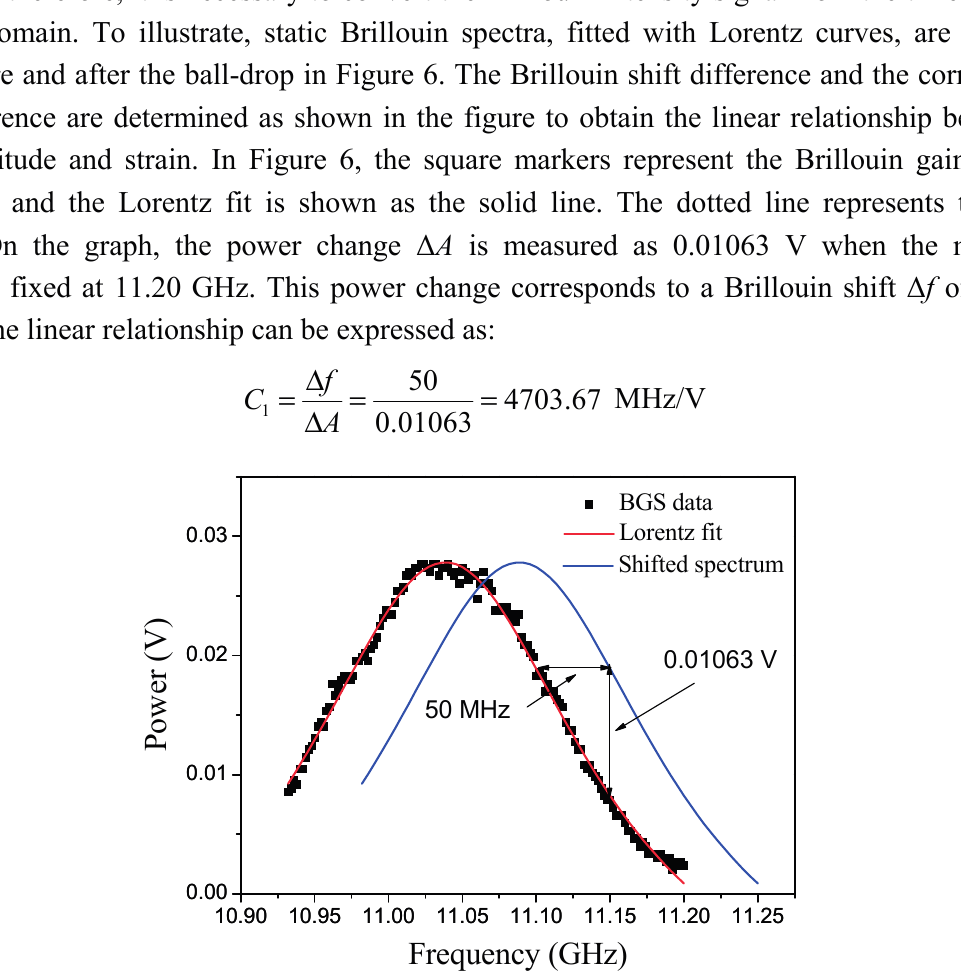
Figure 6. Static spectra before and after the ball drop for Grid